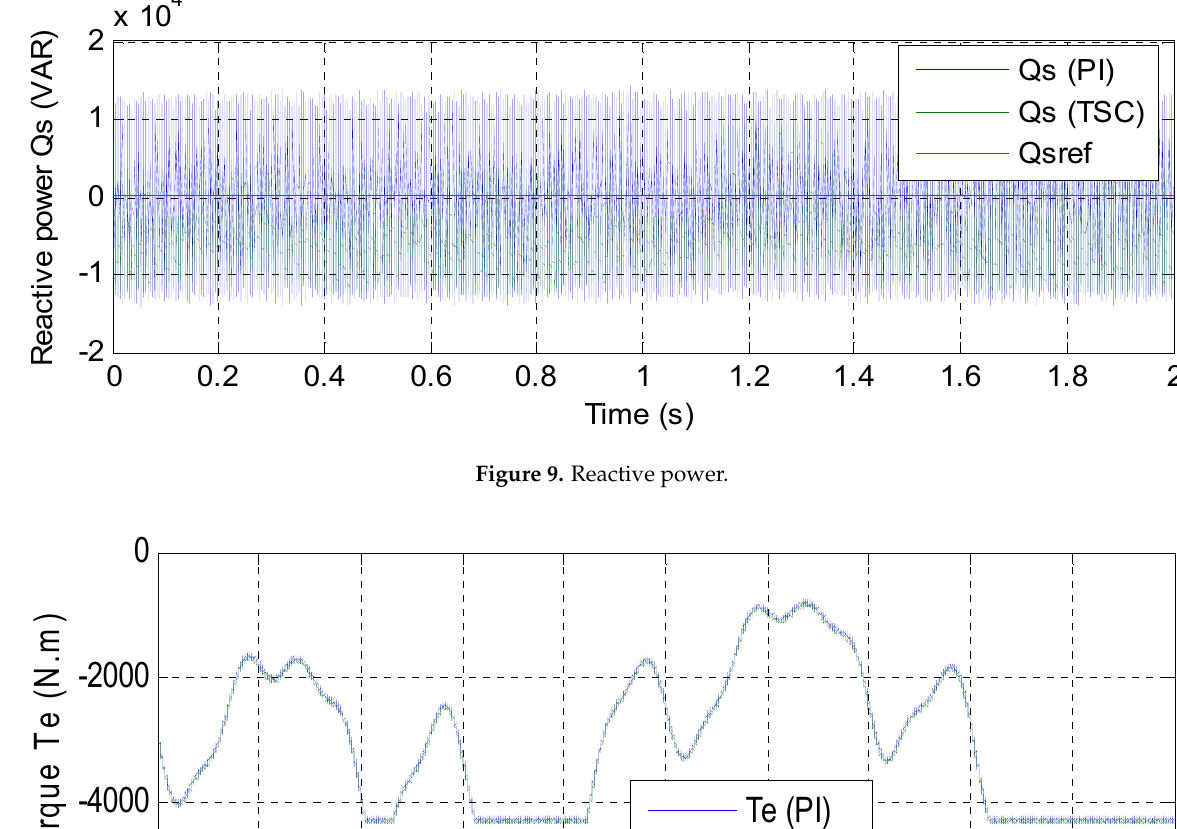
Figure 8. Active power.